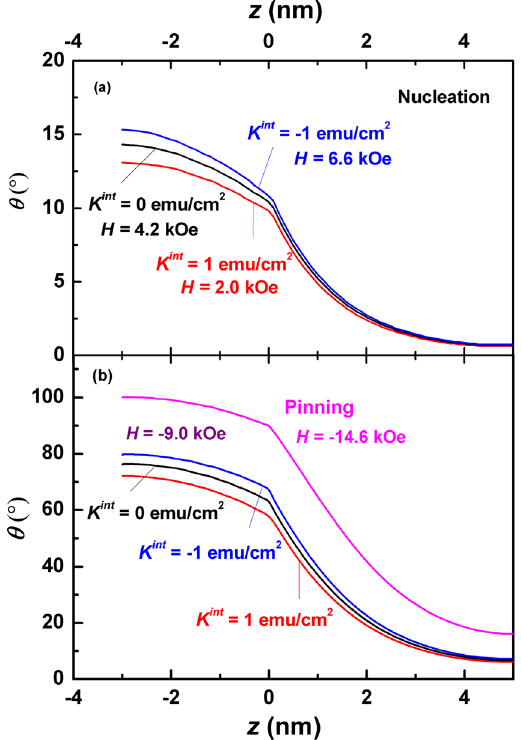
Figure 5. Calculated angular distributions θ ( z ) of the magnetizations in the thickness directions of a Nd 2 Fe 14 B (10 nm)/ α -Fe (6 nm) multilayer for various interface anisotropy and applied fields. ( a ) Angular distributions at the nucleation, where the nucleation fields differ for different anisotropy constants. ( b ) angular distributions at H = − 9.0 kOe and H = − 14.6 kOe (the pinning). It should be noted that the three curves for various values of interface anisotropy degenerate to one single curve at the pinning.